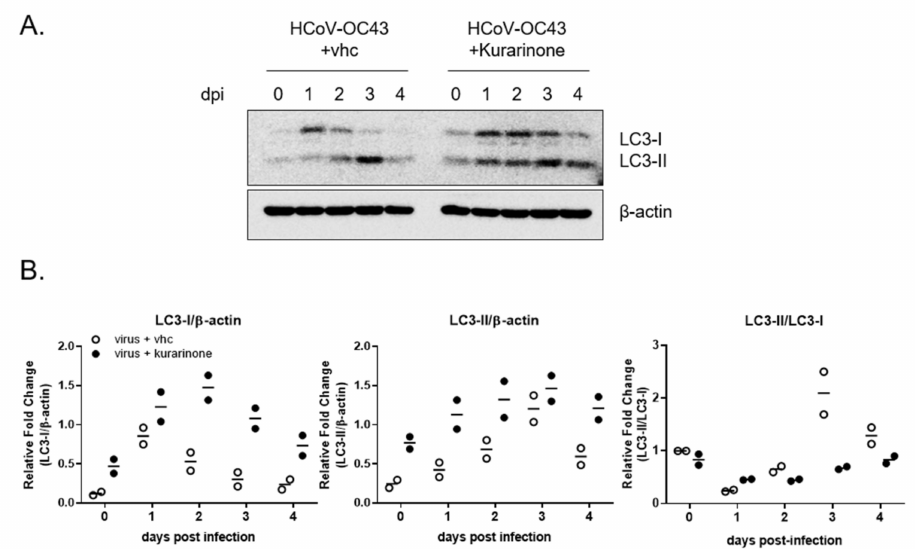
Figure 4. Autophagy induced by HCoV-OC43 infection was impaired by administration of kurarinone; ( A ) MRC-5 cells were infected with HCoV-OC43, treated with kurarinone or vehicle (vhc), and evaluated post-infection (dpi) on days 0, 1, 2, 3, and 4 by Western blot probed with anti-LC3 protein antibody; β -actin was used as the internal loading control. ( B ) The protein band intensities of LC3-I and LC3-II were quantified. Data were presented as means of two independent